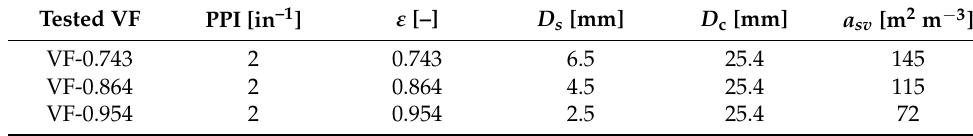
(b) Figure 3. The pulsating velocity examples at the inlet of the computational domain: ( a ) ε = 0.743, Re = 40, ( A / D s ) St = 0.344. ( b ) ε = 0.954, Re = 25, ( A / D s ) St = 0.344. The frequency of pulsation is defined as: